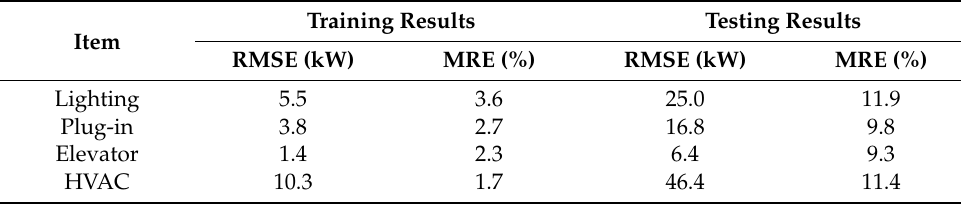
Table 5. Training and testing results of NIM models based on Approach III.